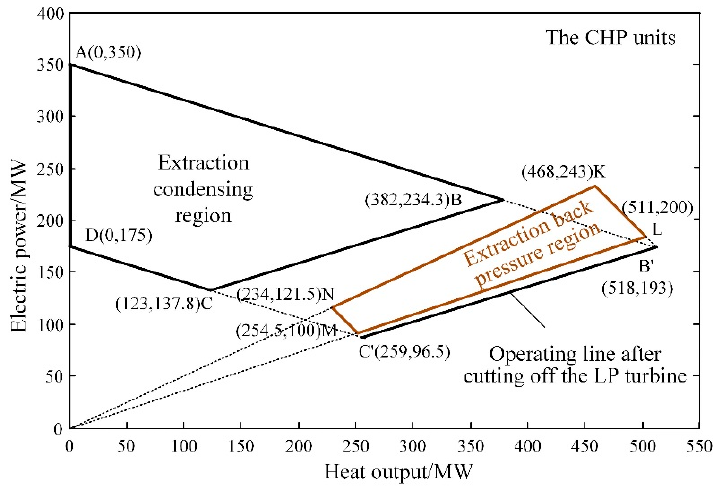
Figure 3. The FORs of three types of Combined Heat and Power (CHP) unit.